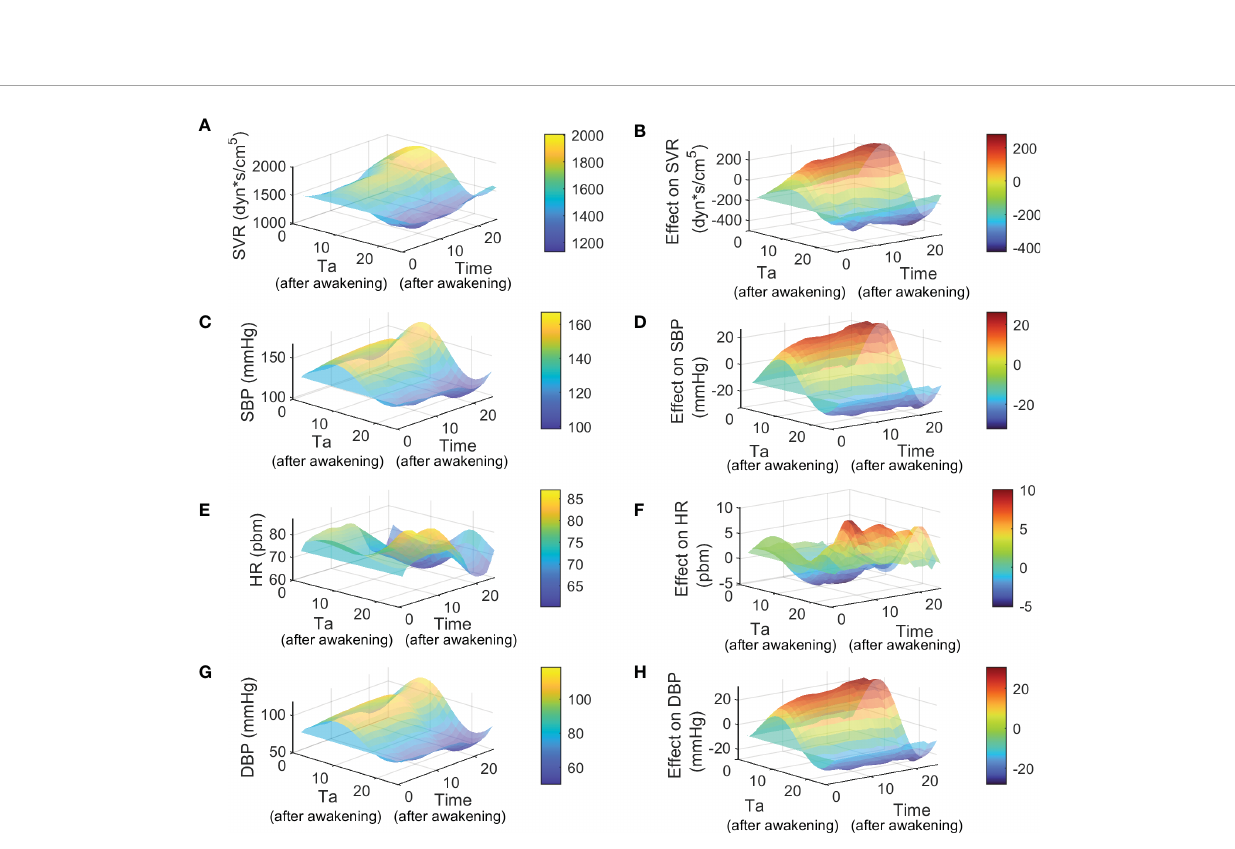
FIGURE 6 Simulation and effect results of Ta-dependent effect model of valsartan using p before of awakening group. Figures (A, C, E, G) show the 24 hours simulation results (hours after awakening) of SVR, SBP, HR and DBP for different Ta from 0 to 24 hours (hours after awakening), respectively. Figures (B, D, F H) show the 24 hours effect results (hours after awakening) of SVR, SBP, HR and DBP for different Ta from 0 to 24 hours (hours after awakening), respectively.